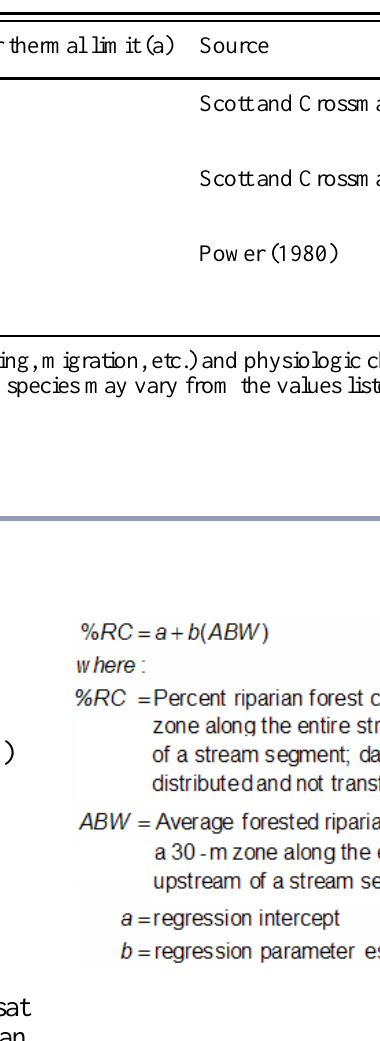
Table 1. Thermal tolerances for trout species found in Georgia. Stocking of rainbow and brown trout has resulted in the establishment of reproducing